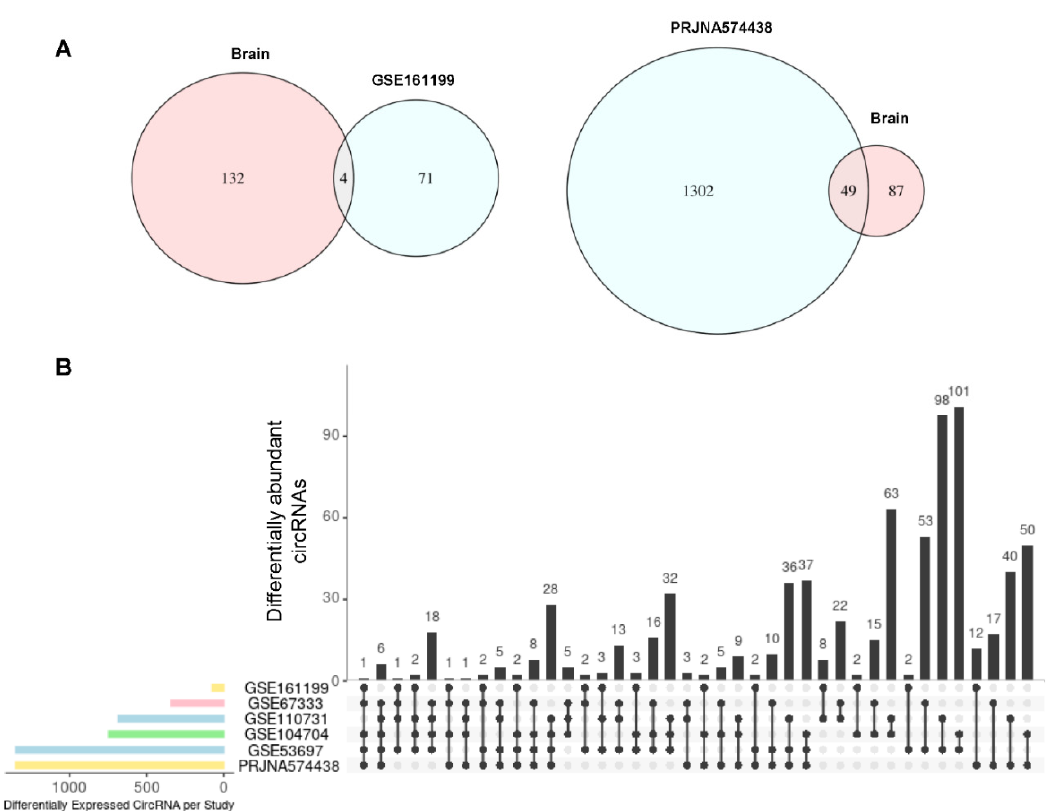
Figure 5. Common differentially expressed circRNAs across all studies. ( A ) Two Venn diagrams depicting differentially expressed circRNAs that were found in at least three of the four brain studies and each plasma study individually. ( B ) An upset plot (see Figure 3 legend) showing the differentially expressed circRNAs (with expression levels significantly increased or decreased) that were shared across all studies, brain and plasma.